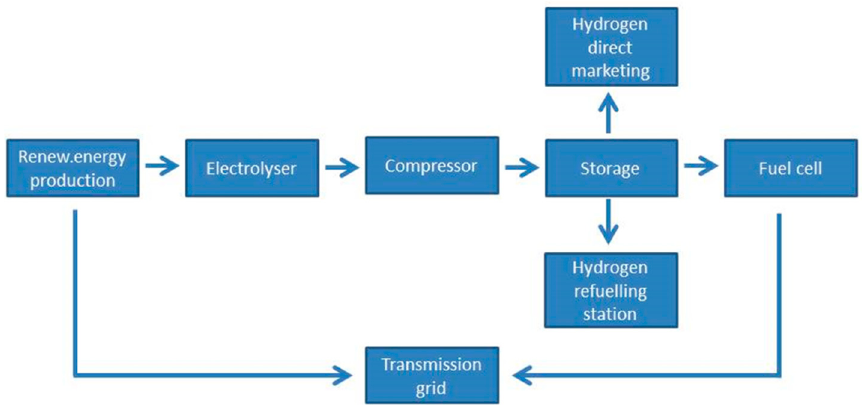
Figure 1. Scheme of a renewable hydrogen storage system.